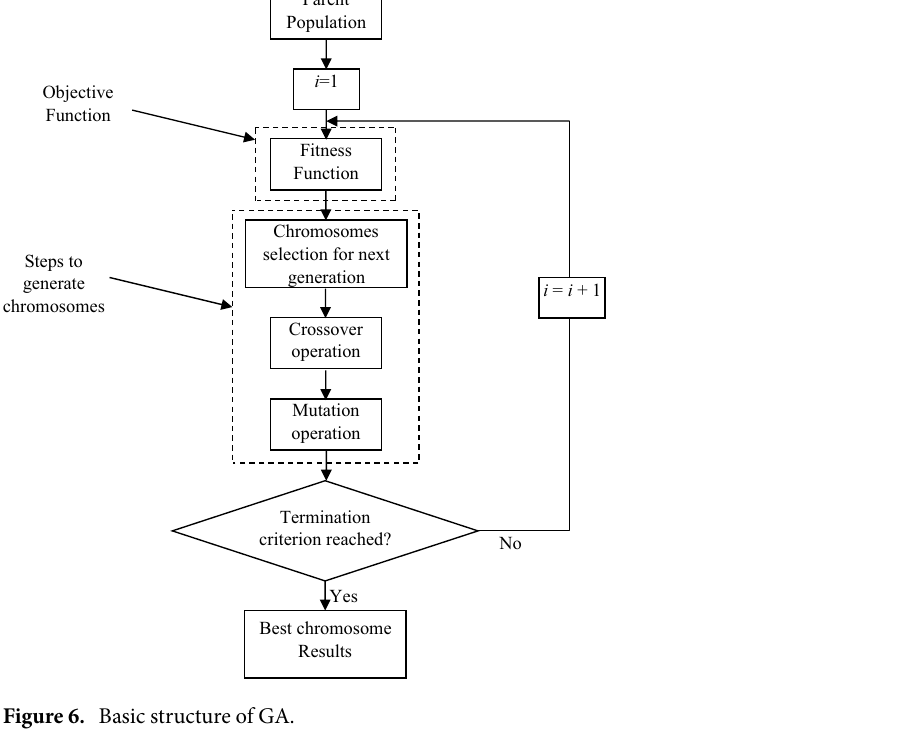
Figure 6. Basic structure of